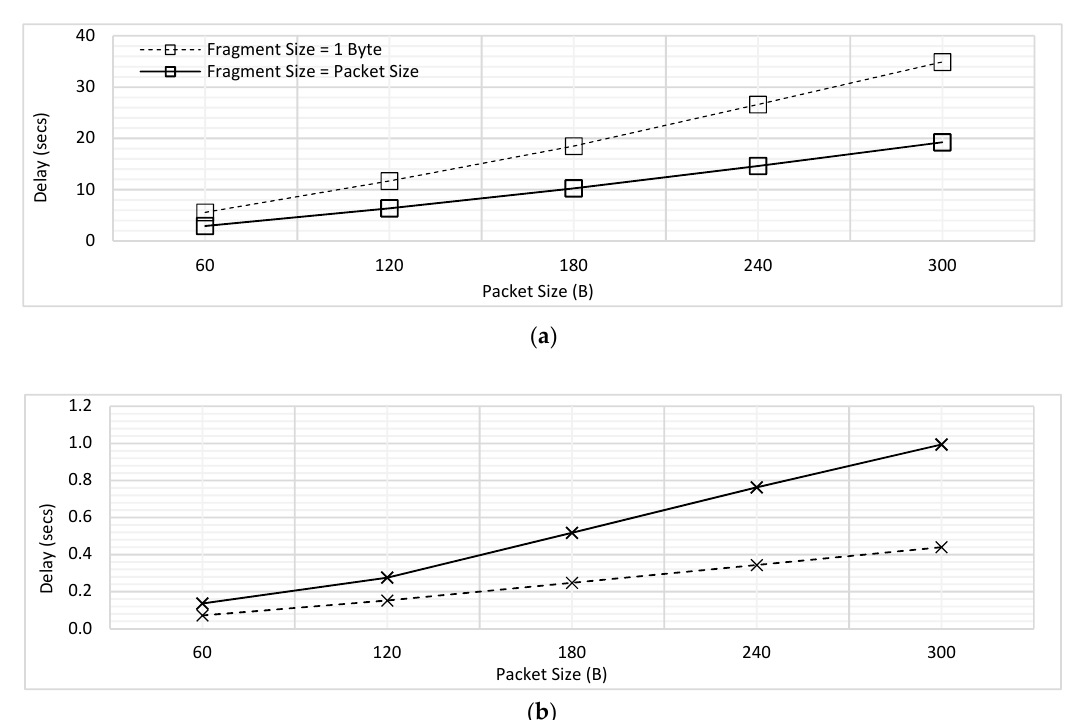
Figure 11. PDR for Prioritization using Fragmentation (Fragment Size = 1B).